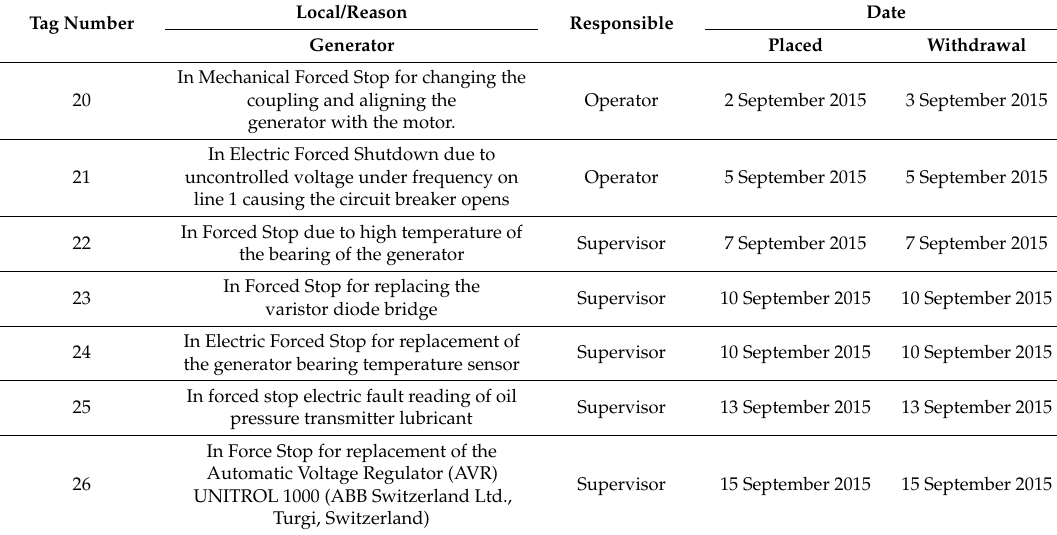
Table 1. Failure Analysis in December 2015.